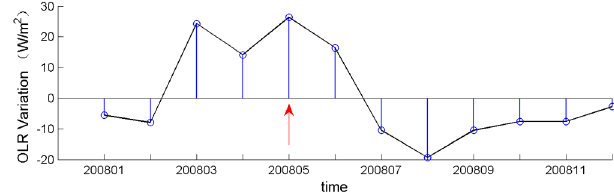
Fig. 3. Abnormal OLR evolution on the point 30 ◦ N, 102.5 ◦ E in 2008 (red arrow points to the month in which earthquake happened).